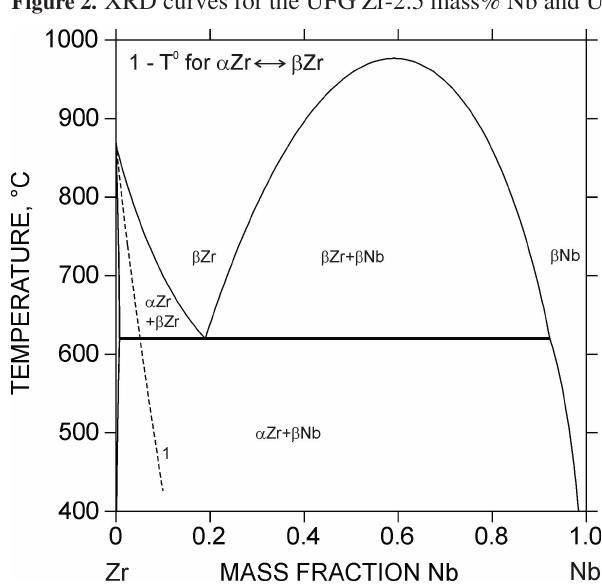
Figure 2. XRD curves for the UFG Zr-2.5 mass% Nb and UFG Zr-8 mass% Nb allos after HPT.